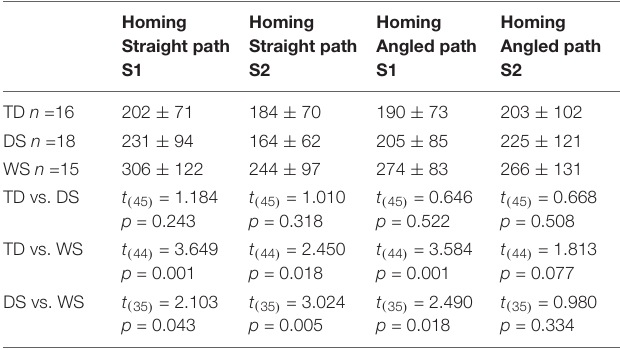
TABLE 5 | Homing task. Homing Straight path